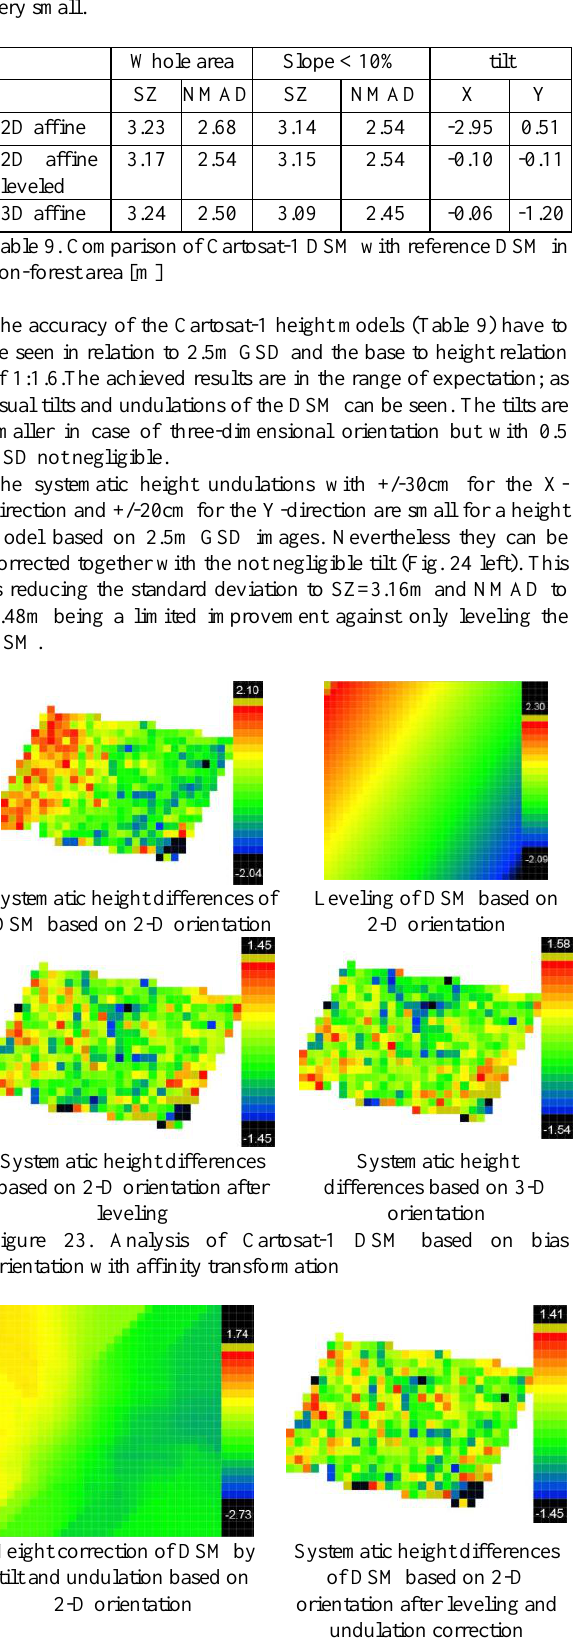
Figure 24. Final correction and remaining systematic errors